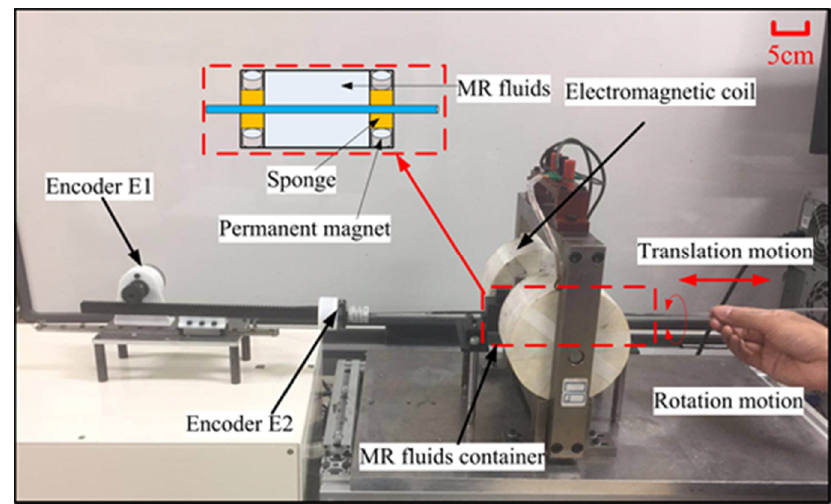
Figure 3. A prototype of the master haptic interface.